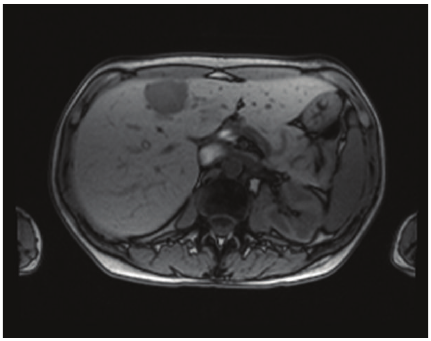
Figure 1: Non-FDG avid liver lesion on PET/CT.